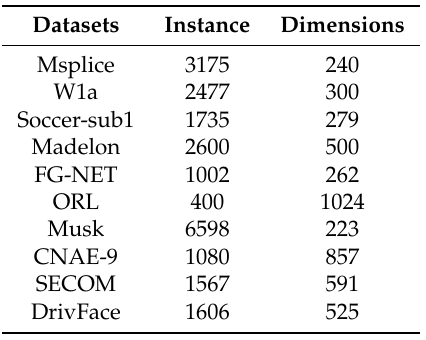
Table 1. Statistics of datasets used for